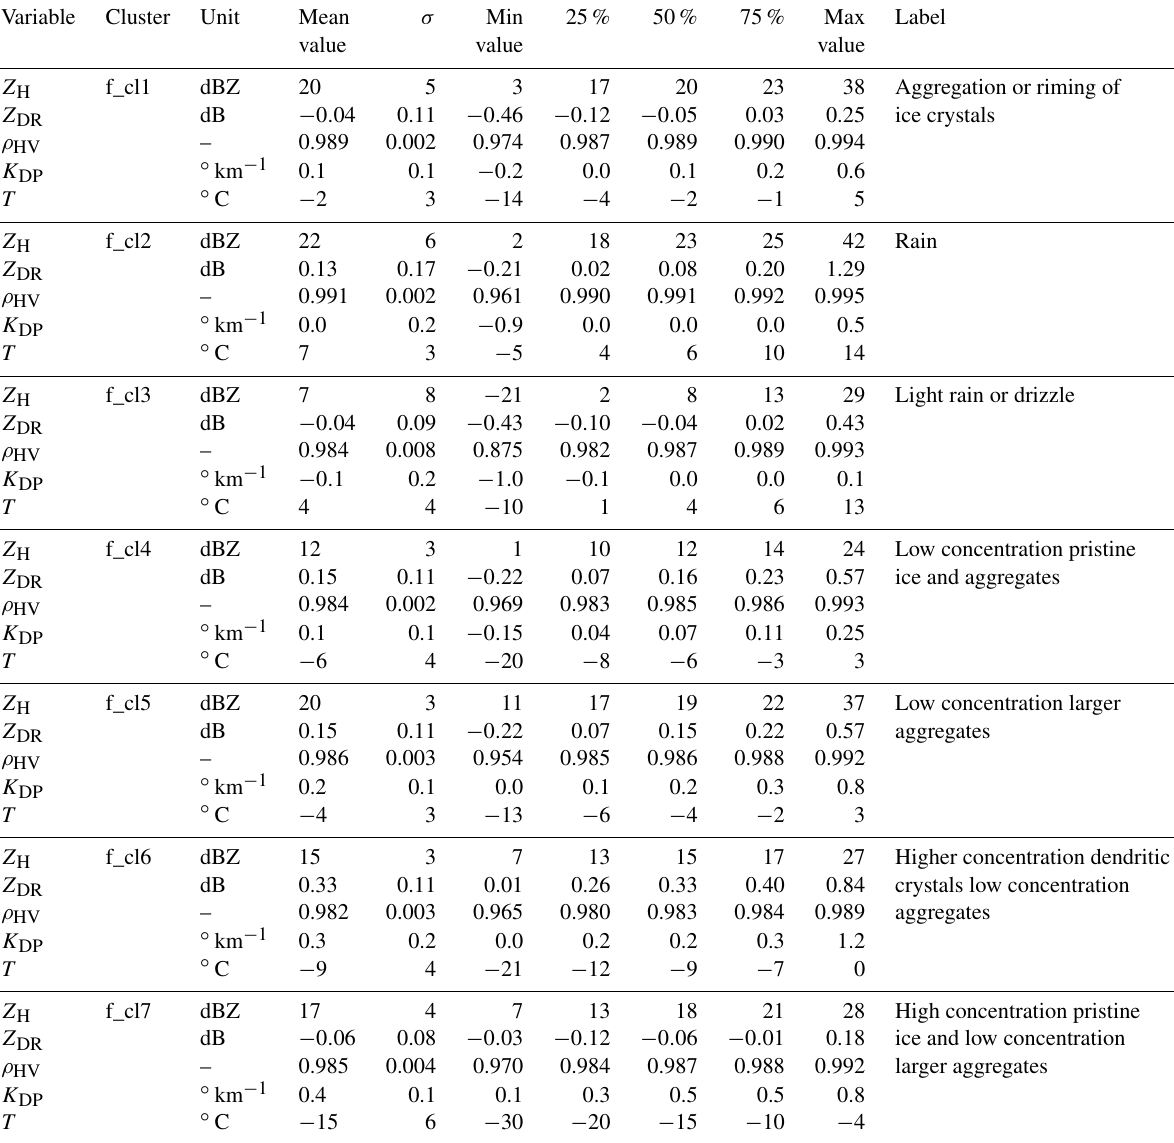
Table A1. Statistics describing the content of the 13 optimal clusters identified in Sect. 4. For each polarimetric variable and for each cluster, we provide the mean value, the standard deviation σ and [minimum, maximum]